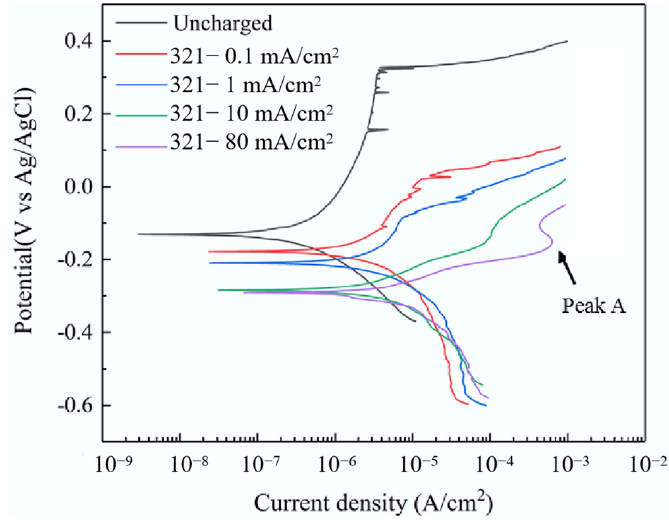
Figure 6. The polarization curve of 321 stainless steel with different hydrogen charging current densities in 1 wt% NH 4 Cl aqueous solution. Table 4. The obtained results from polarization curve test under different conditions.